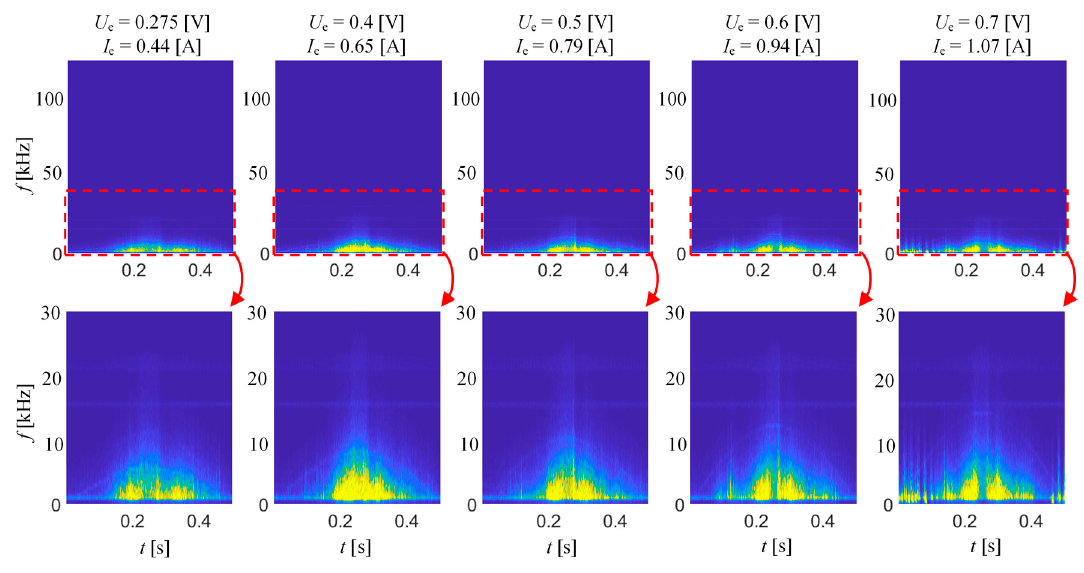
Figure 4. BN TF_S spectrograms obtained for excitation frequency of 1 Hz and various excitation voltage level.